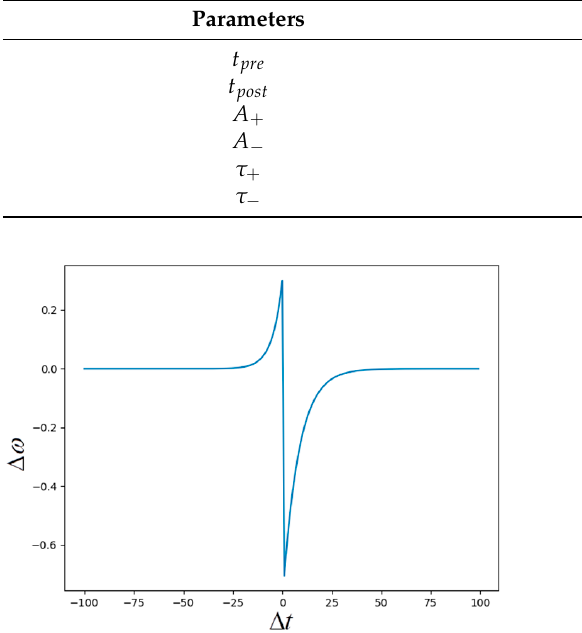
Figure 5. Curve of STDP Algorithm.